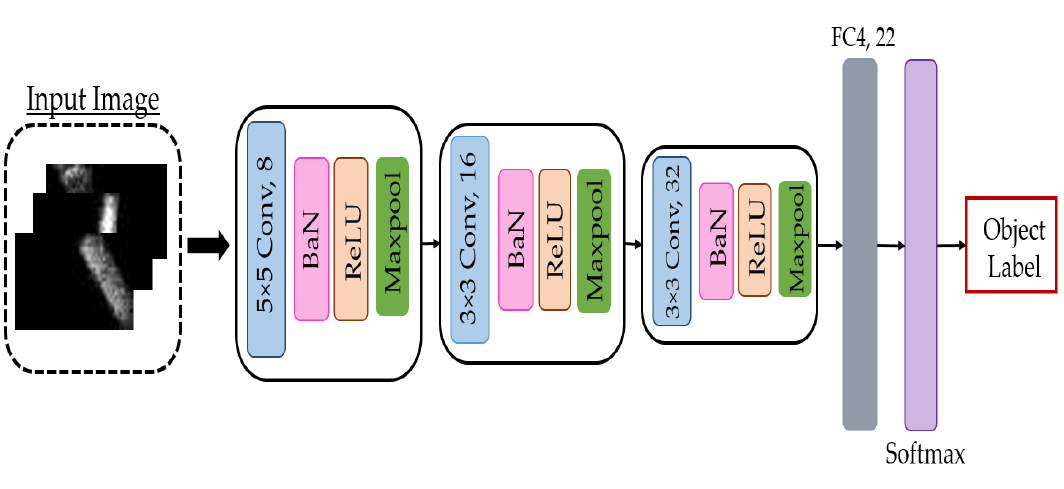
Figure 3. Architecture of the tested model. BaN, Batch